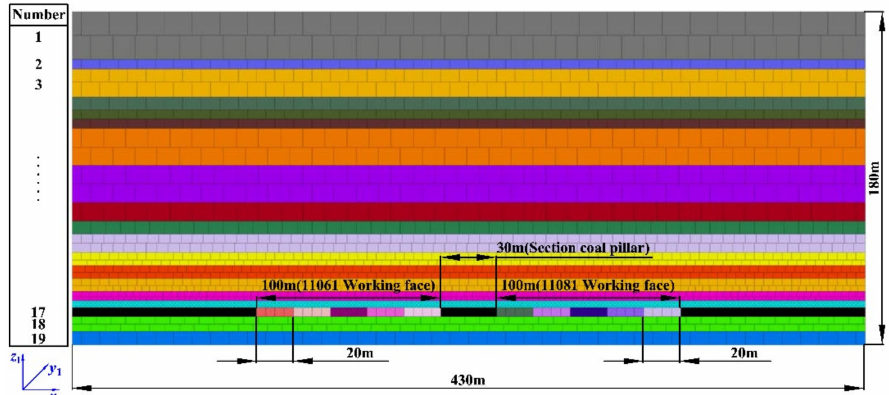
Figure 3. Dip model of the adjacent working face (30 m section coal pillar as an